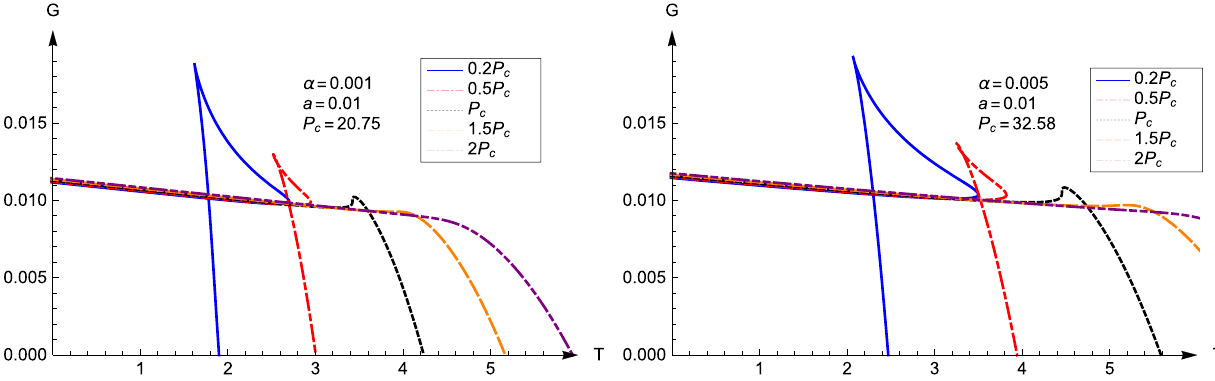
Fig. 4 Gibbs free energy versus T for a = 0 . 01 and α = 0 . 001 (left panel), and α = 0 . 005 (right panel)